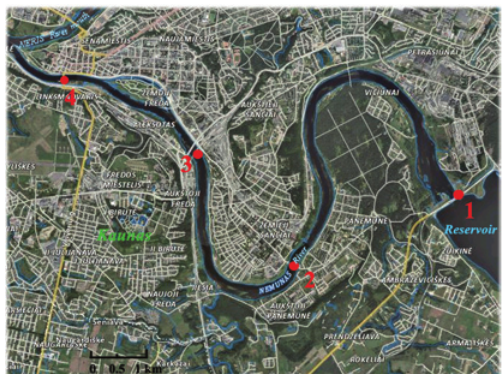
Fig. 1. The stretch of Nemunas River under study, water level measuring points: 1 – Kaunas HPP; 2 – Panemune Bridge; 3 – Railway Bridge; 4 – Aleksotas